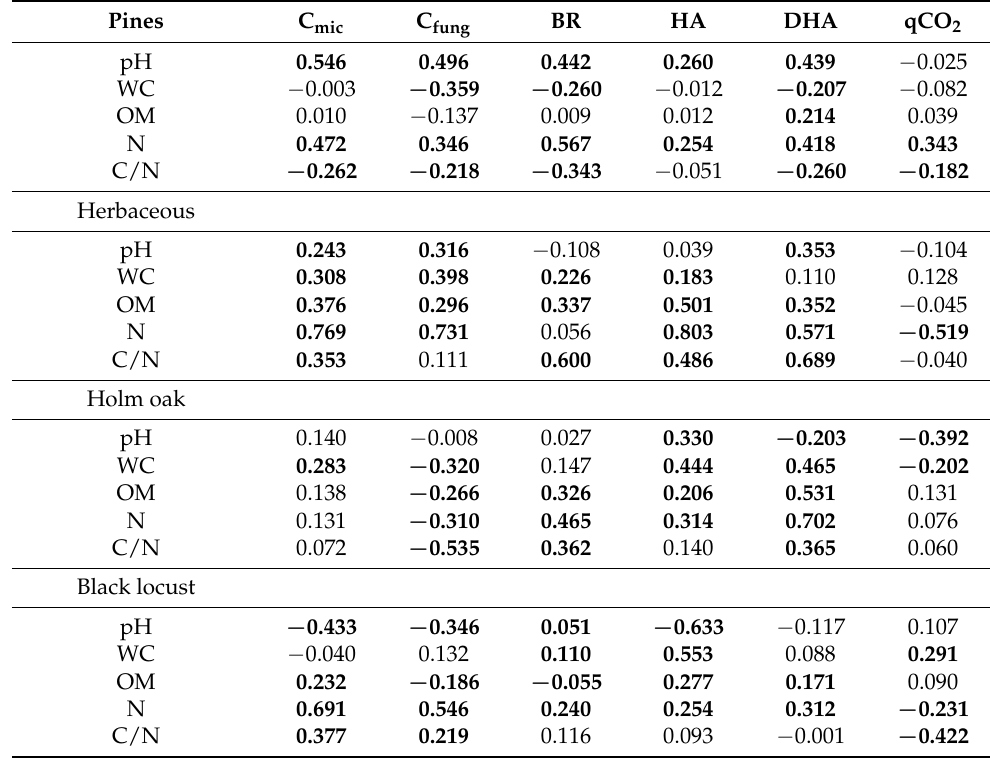
Table 3. Coefficient of Spearman’s correlation performed between physico-chemical and biological parameters of the soils sampled after the